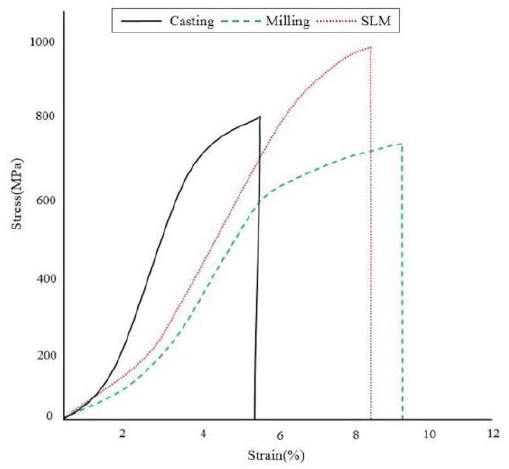
Figure 1. Stress–strain curves of tensile strength test following different manufacturing techniques.